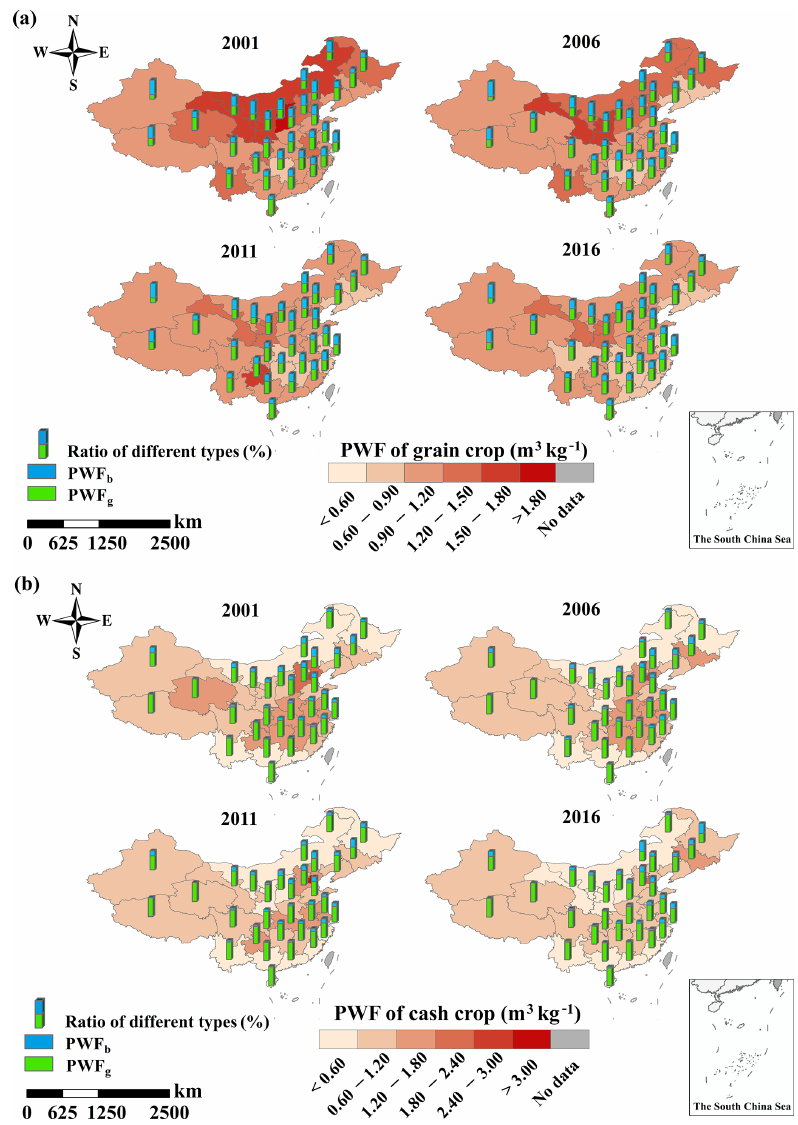
Figure 3. Temporal and spatial evolution of production-based water footprint (PWF) of (a) grain and (b) cash crops in China.